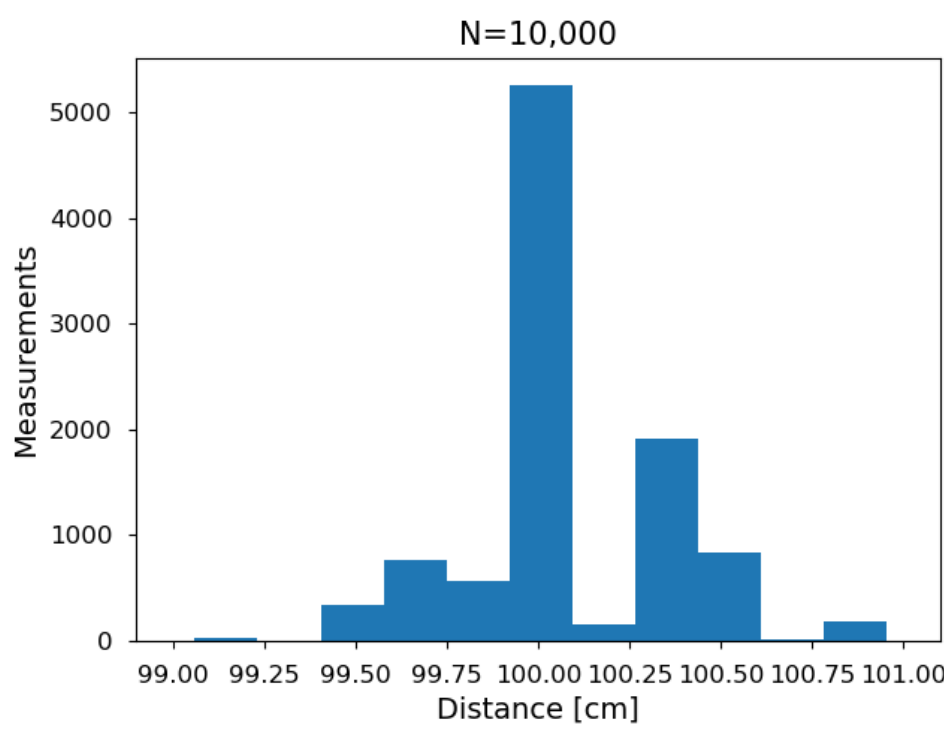
Figure 5. Histogram of 10,000 distance measurements of static obstacle located at one meter from the HC-SR04 sensor. It is centered at 100 cm and spreads over a bit less than two centimeters with 0.269 standard